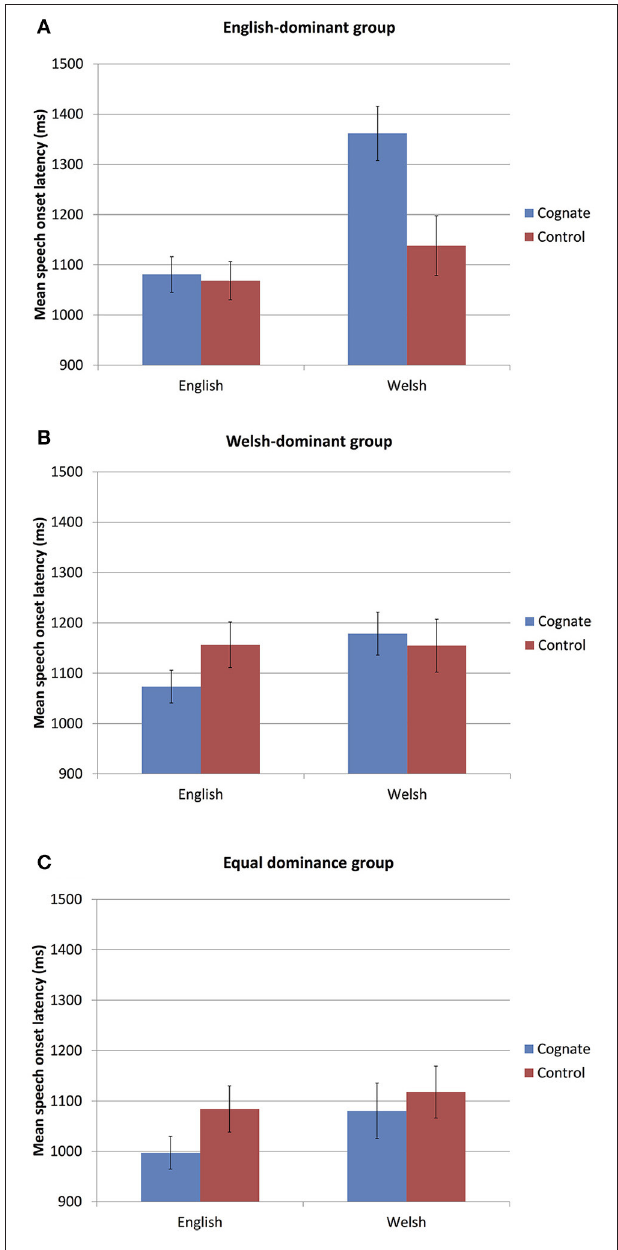
FIGURE 1 | (A–C) Mean naming latencies for Cognates and Controls in each Language Dominance group ( A , English-dominant; B , Welsh-dominant; C , equal dominance) and in each Target Language. Error bars represent the standard error of the mean across participants and are for illustrative purposes